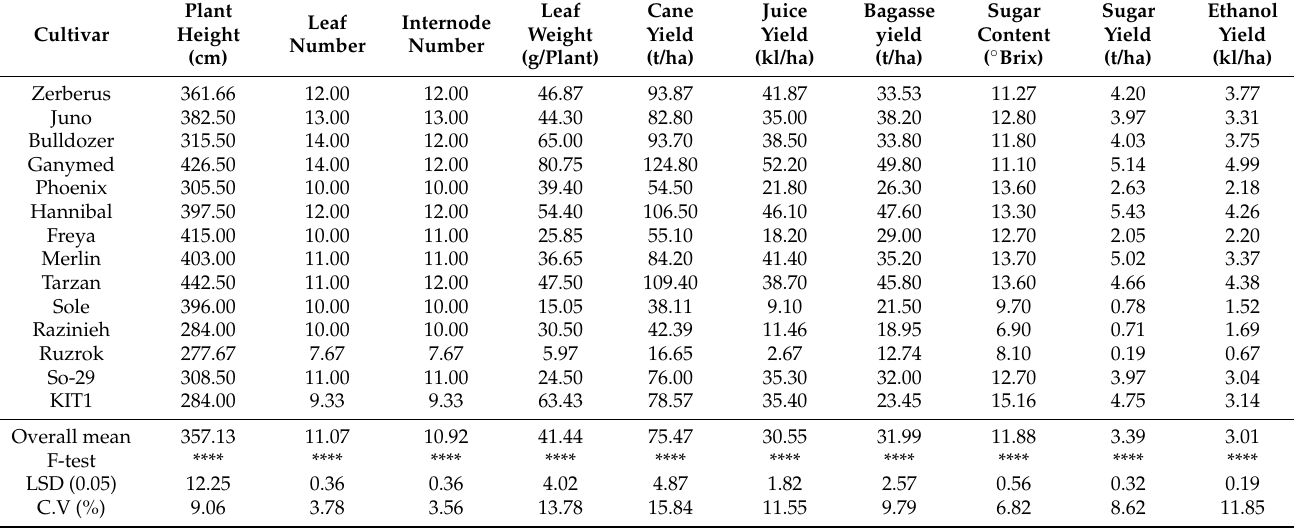
Table 2. Mean values of agro-morphological traits recorded from 14 sweet, grain, and dual-purpose sorghum genotypes, their grouped overall mean values, least significant difference, and coefficient of variation as percentage (C.V%) at dough stage under temperate climatic